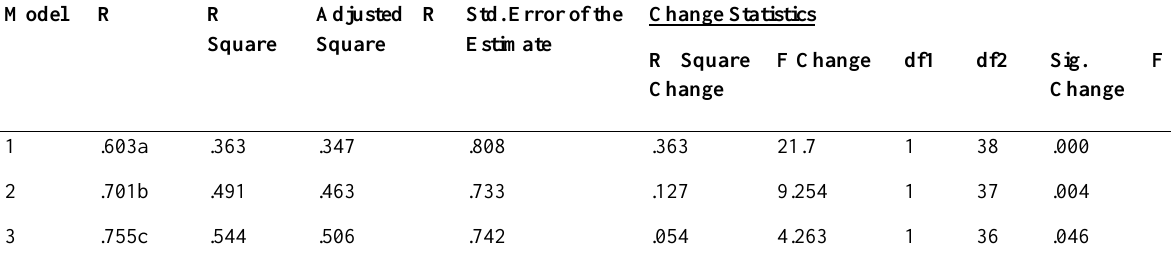
Table 5: MMR model summary for the moderating effect of Service Innovation on Corporate Reputation and Performance